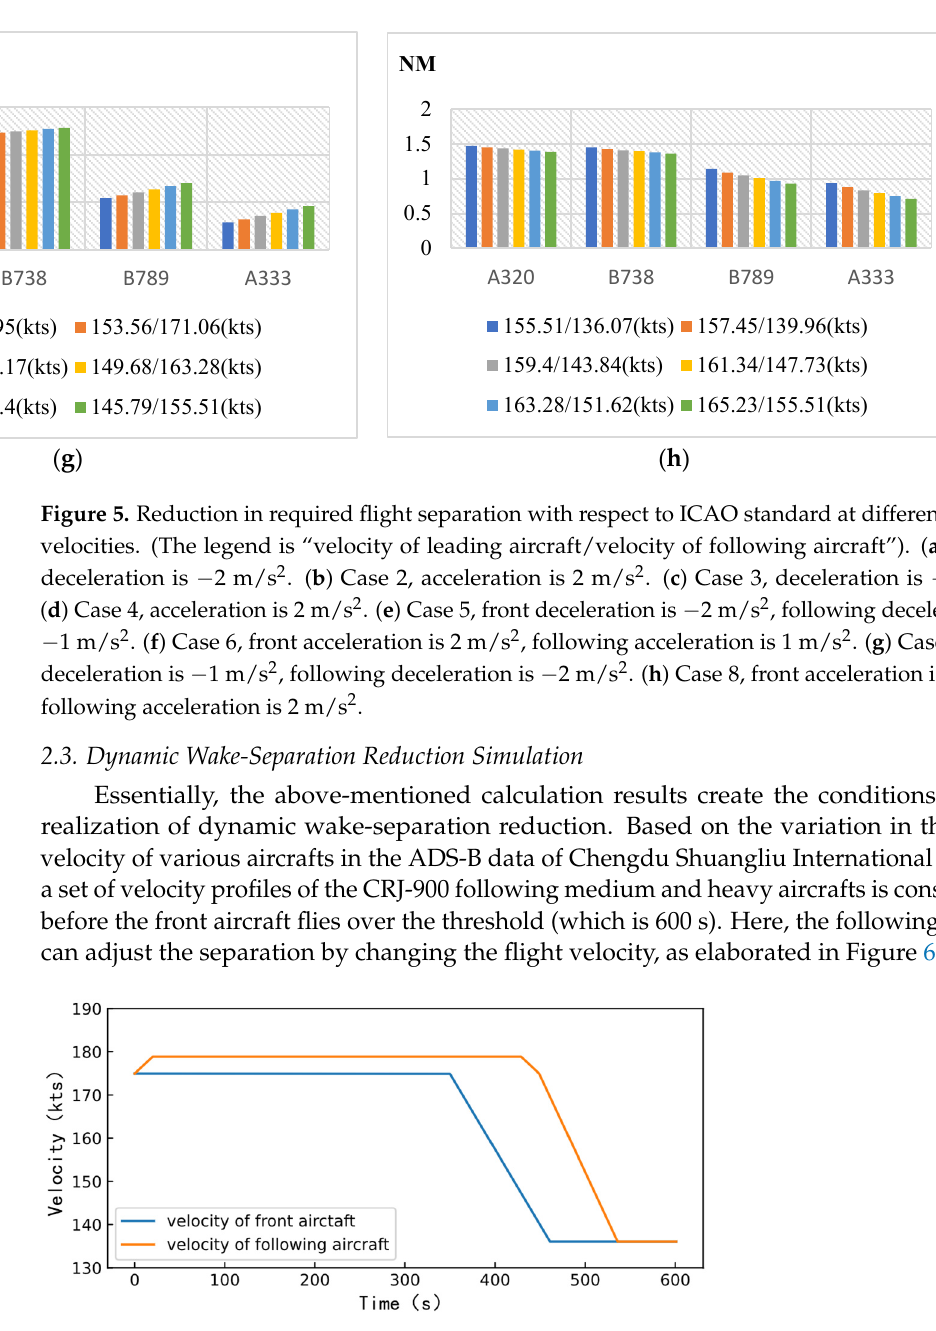
Figure 7. Dynamic separation change when CRJ-900 follows a medium aircraft.